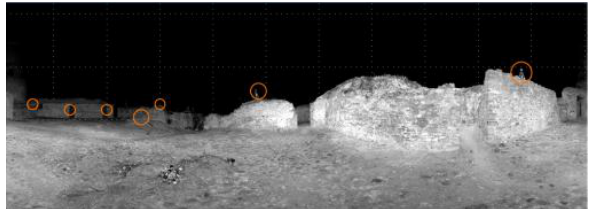
Figure.3 Distribution of marked check